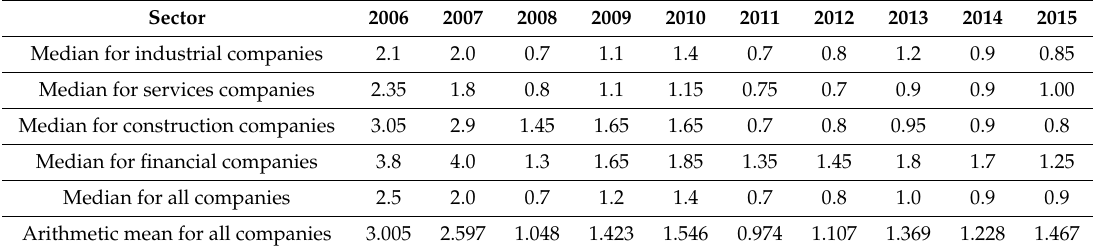
Table 4. Mean value of Tobin’s Q by sector and year, and untransformed